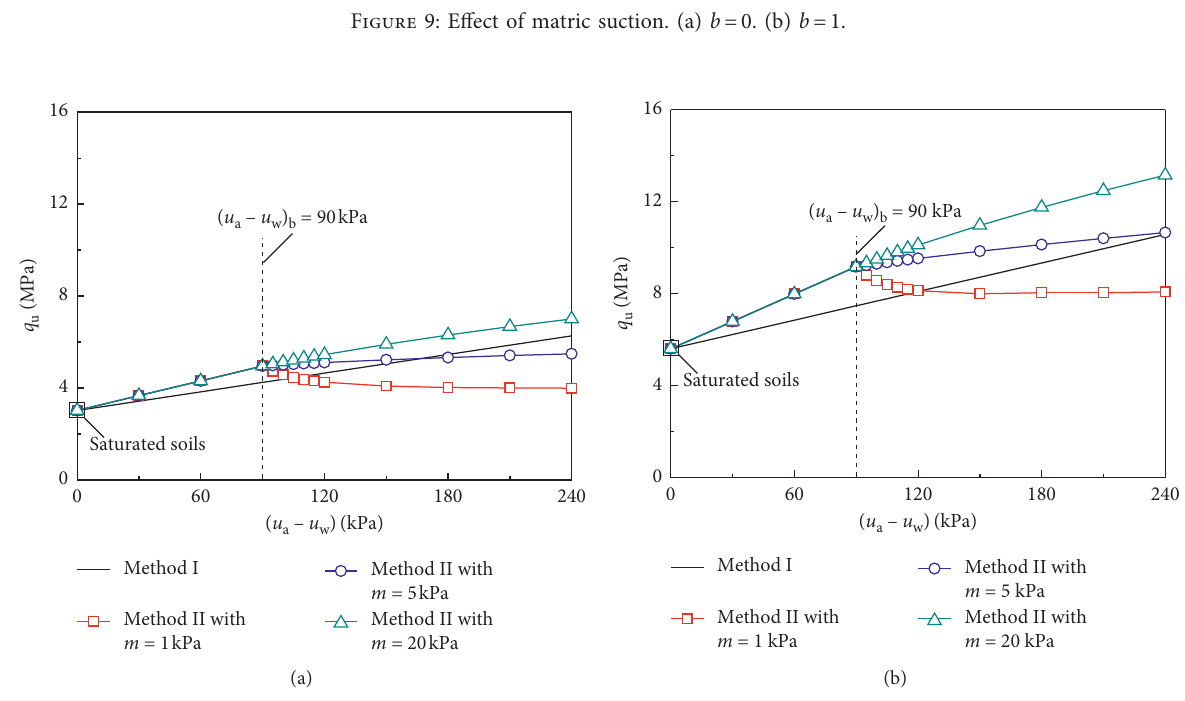
Figure 10: Effect of strength nonlinearity. (a) b � 0. (b) b �